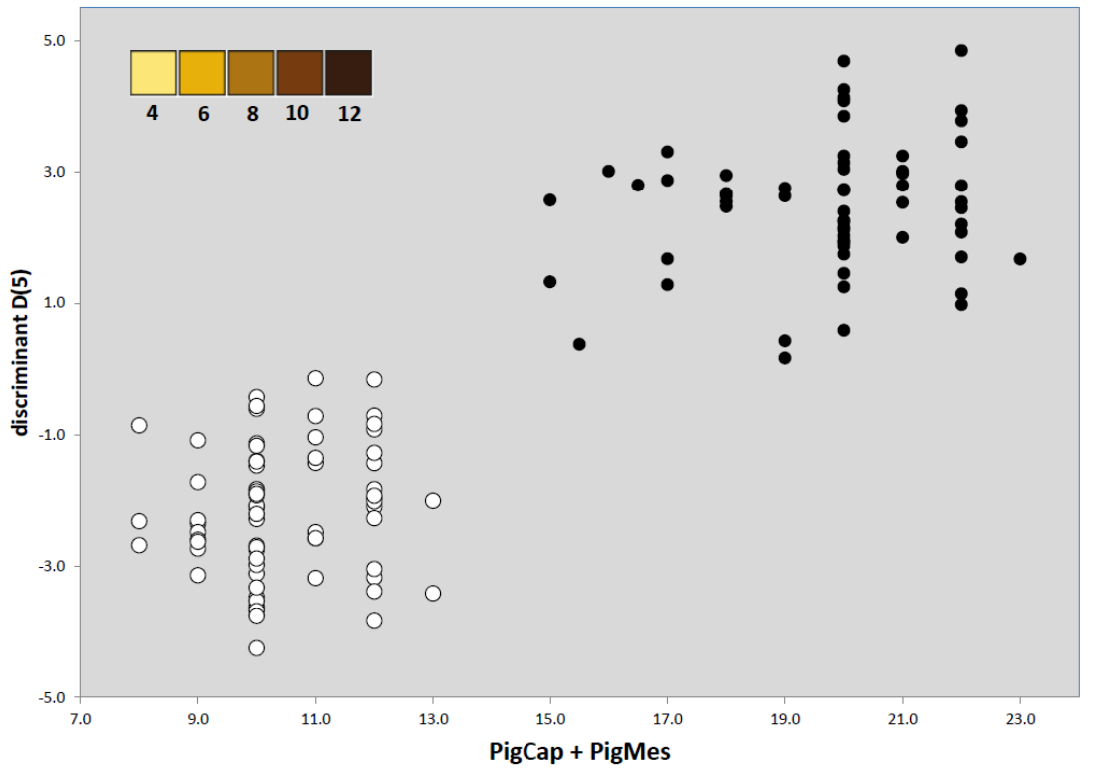
Figure 31. Separation of 131 worker individuals of Cardiocondyla micropila n.sp. (white dots) and C. latifrons n.sp. (black dots) by a linear discriminant considering the morphometric characters CS, sqPDG, PLG/CS, EYE/CS and SPBA/CS and the sum of pigmentation scores of head (PigCap) and mesosoma (PigMes). The color chart upper left visualizes the scores.